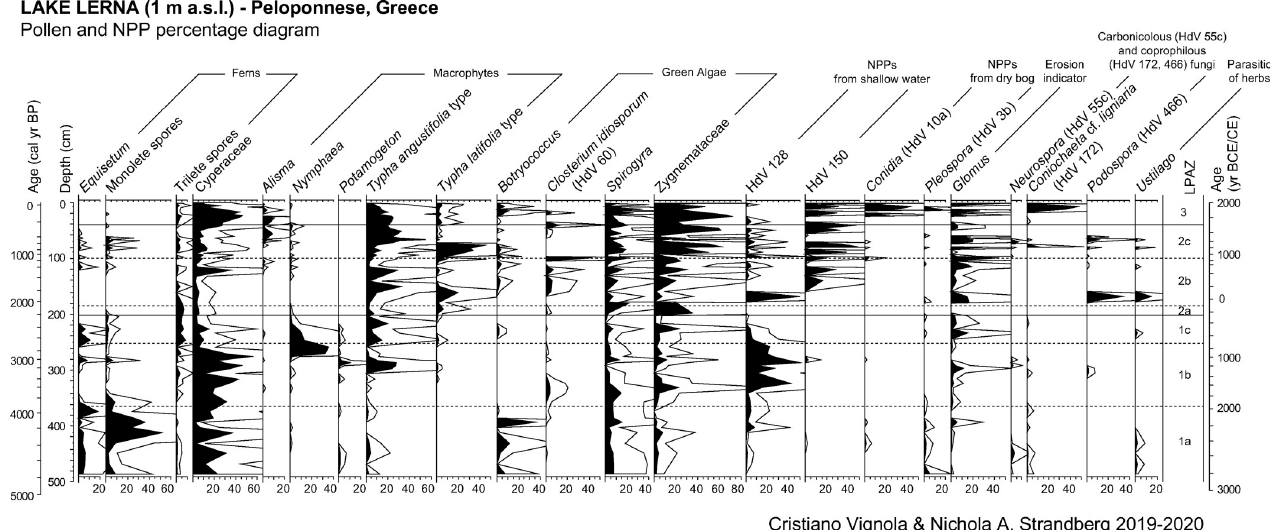
Fig 5. Results of pollen analysis of the study core from ancient Lake Lerna (Peloponnese, Greece). Pollen percentage diagram of selected aquatic and NPP taxa. Curve magnification 4x.